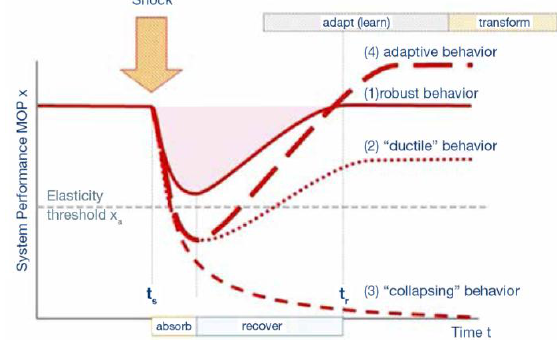
Fig. 2. Main regularities of the system stable and unstable